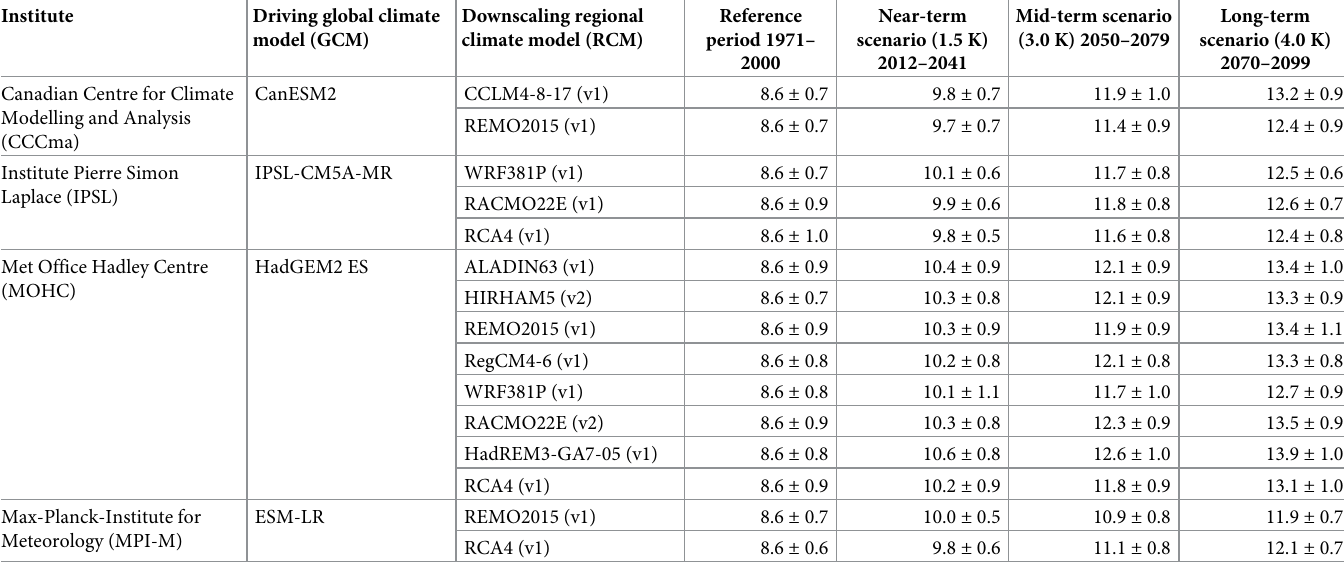
Table 1. Overview of EURO-CORDEX simulations used as model input.